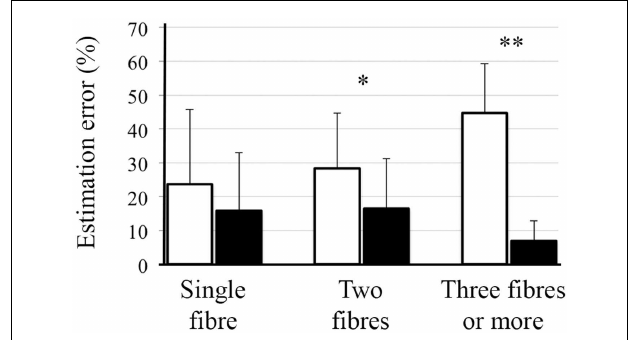
FIGURE 10 | Mean and SD of error in estimation of number of fibers, using CSD (white bars) and lop-CSD (black bars), compare with estimated values from gold standard data (see Method) . * and ** indicate significant levels of p < 0.01 and p < 1e − 10, respectively. Paired t -test was